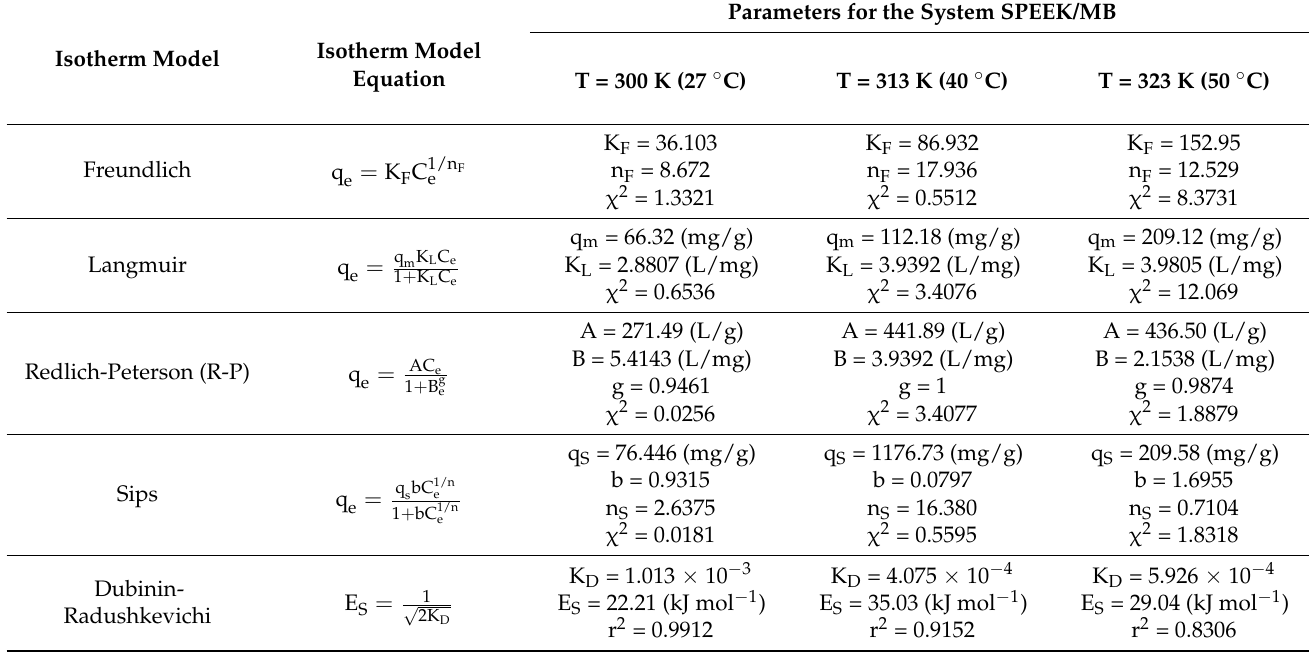
Table 2. Isotherm models and parameters for MB dye adsorption onto polymeric beads SPEEK, experimental conditions: SD = 2 g/L, t = 180 min, and pH 6.0 ±